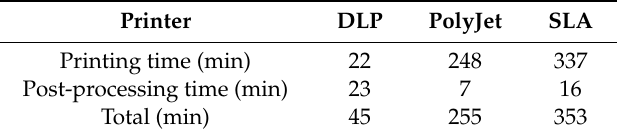
Table 3. The comparison of processing and post-processing time among DLP, PolyJet, and SLA 3D